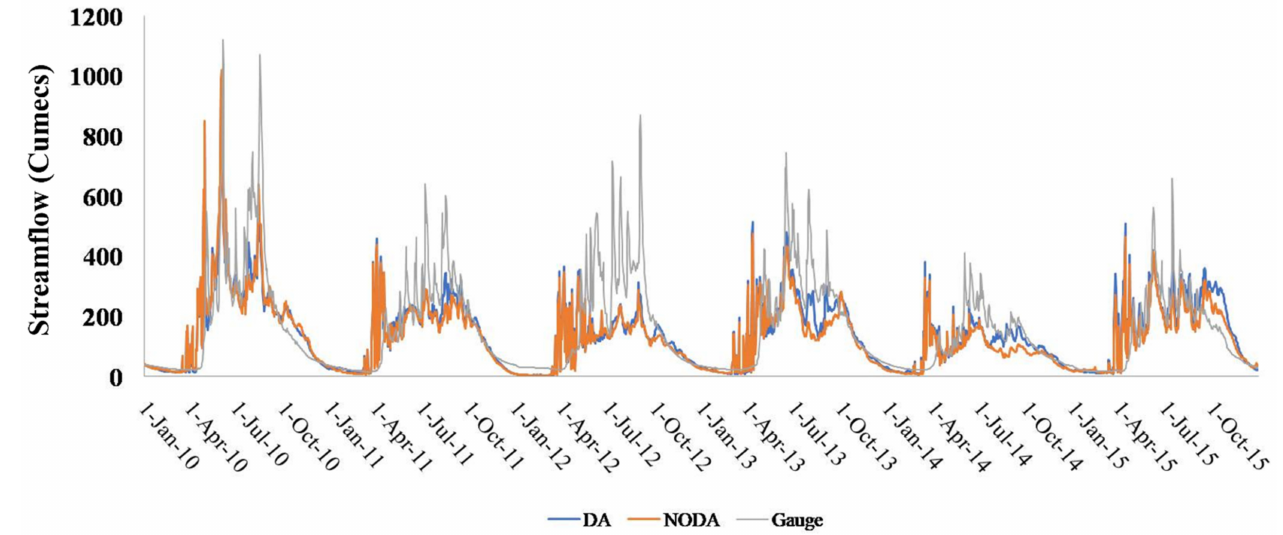
Figure 11. Time-series of streamflow with respect to gauge data over